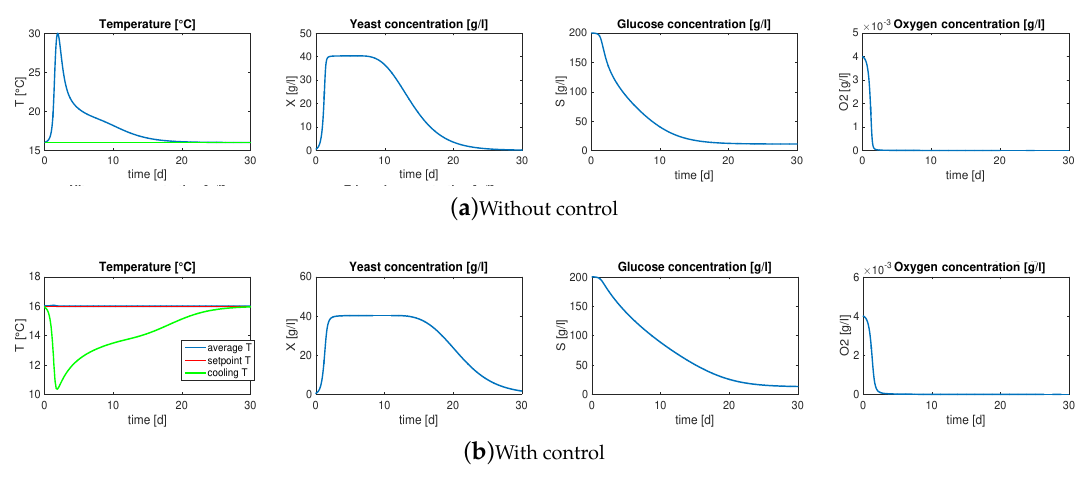
Figure 1. Model dynamics. ( a ) Average behaviors of must main components during 30 days of fermentation, the temperature of the cellar and the temperature of the cooling water are constant all over the process, i.e., T ext = T u = 16 ◦ C. ( b ) Average dynamics of the bioreactor where a PID controller with gain scheduling drives the cooling/heating system in order to keep the temperature at the optimal value 16 ◦ C.